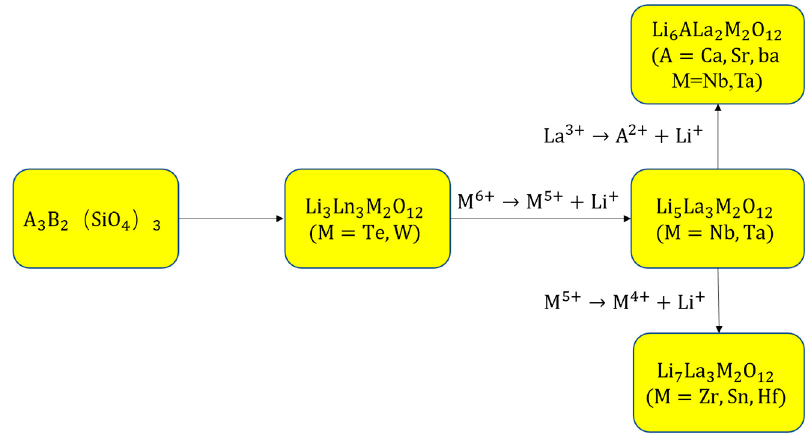
Figure 1. Different composition of garnet-type Li-ion conductors.